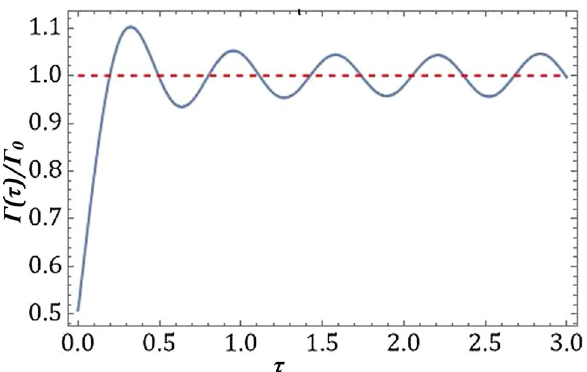
, τ 0 = ¯ h Γ is the lifetime, t is the 0 0